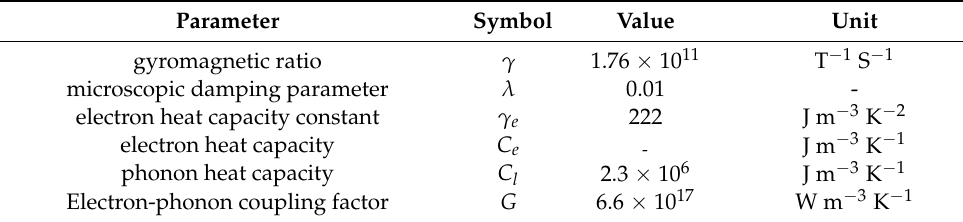
Table 2. The physical parameters in two-temperature model. Parameter Symbol Value Unit gyromagnetic ratio microscopic damping